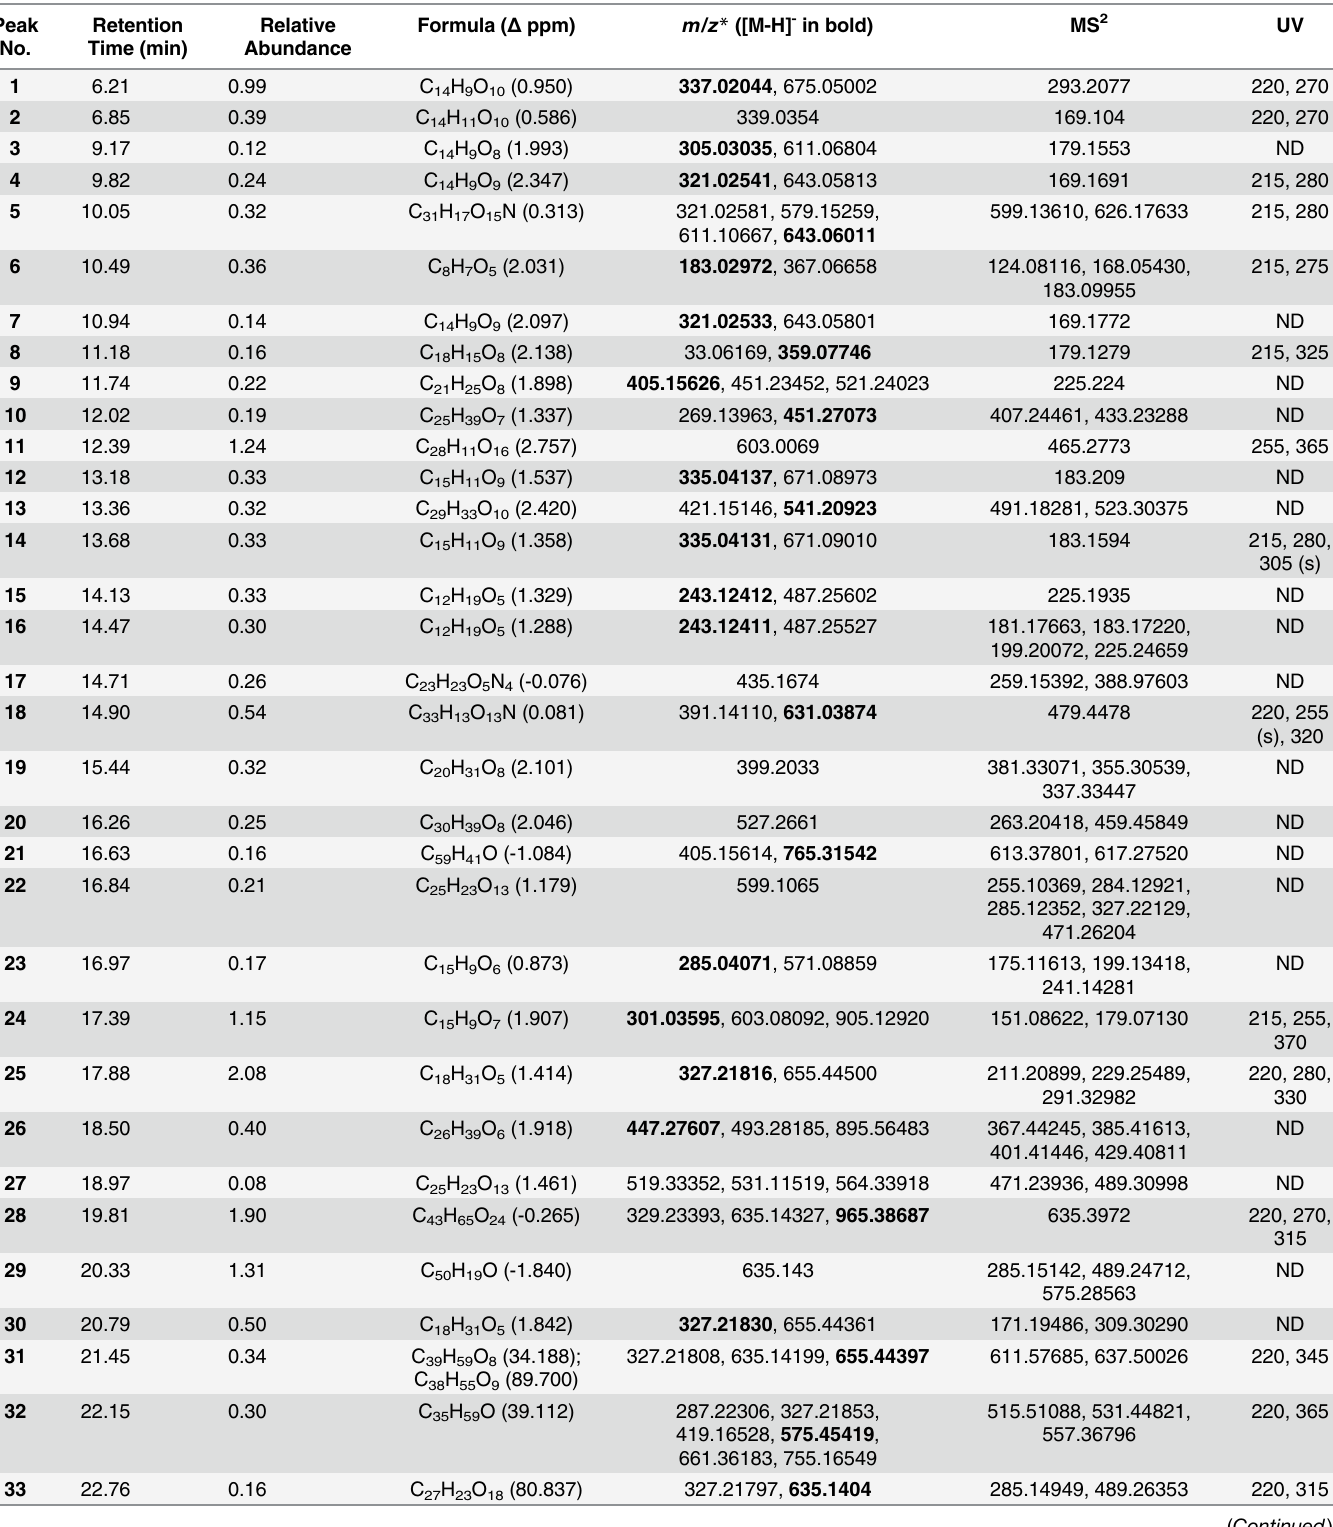
Table 5. Mass spectrometry (m/z) analysis of 224C-F2. The corresponding chromatogram is reported in Fig 9; putative structures in Figs 10 and 11. Peak